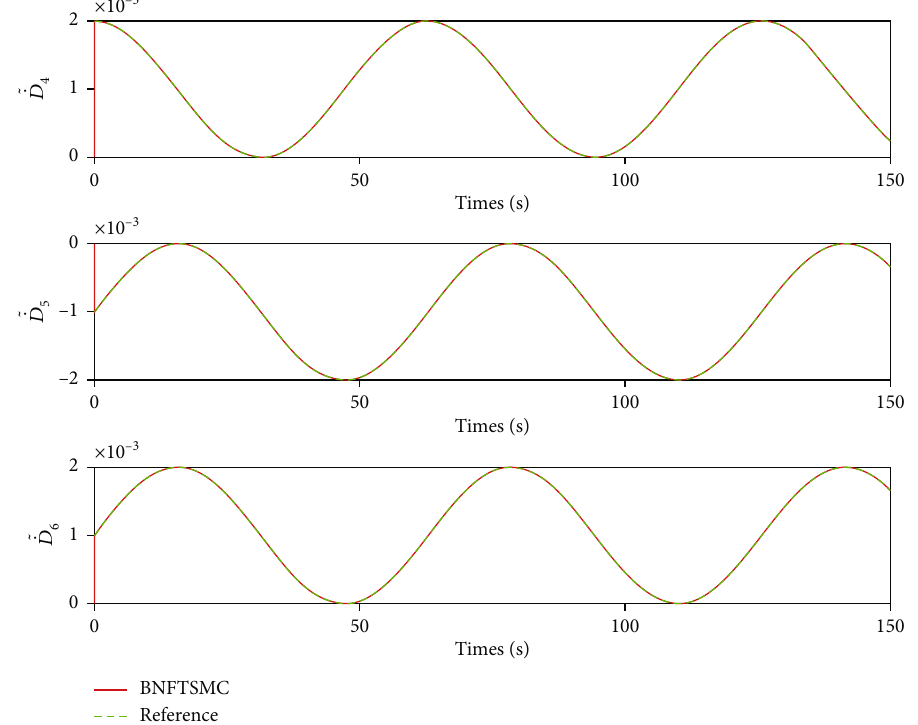
Figure 17: Estimation of the disturbances in position